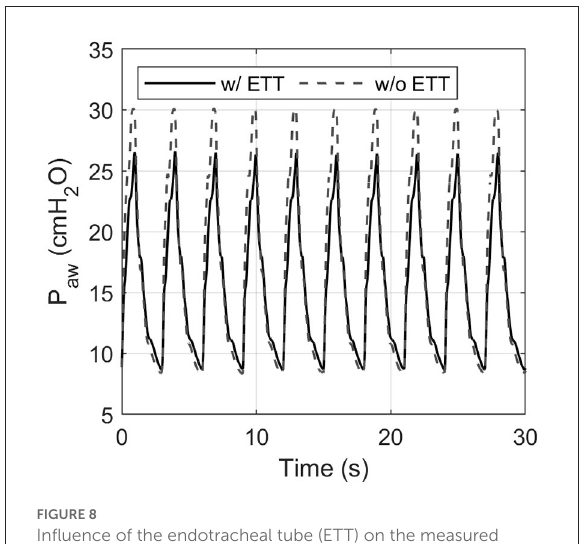
FIGURE8 Influence of the endotracheal tube (ETT) on the measured airway pressure shown for the HEV ventilator. The ETT introduces additional flow resistance, resulting in a considerably lower peak pressure. This effect was evident in each ventilator